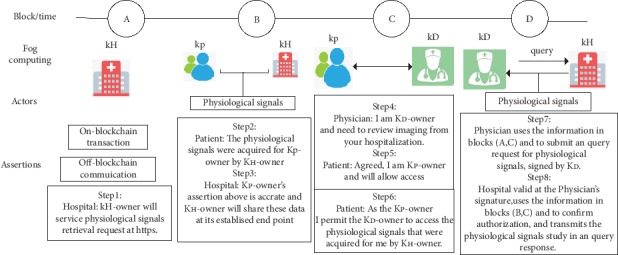
Blockchain medical data sharing sequence diagram based on fog computing.